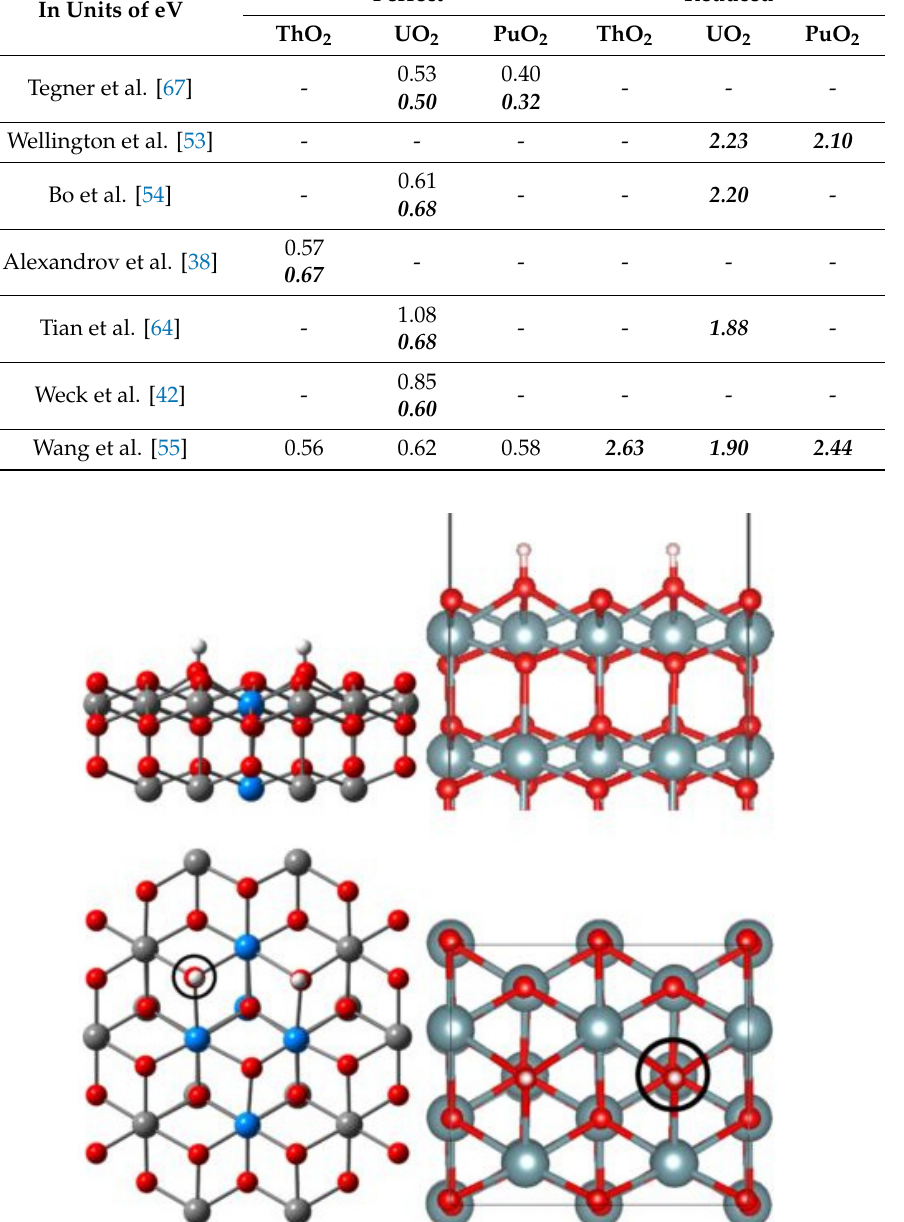
Table 6. Adsorption energies of one H 2 O molecule on AnO 2 (111) surface. The bold italic numbers correspond to the dissociative adsorption energies. The rest are the molecular adsorption energies. In Units of eV